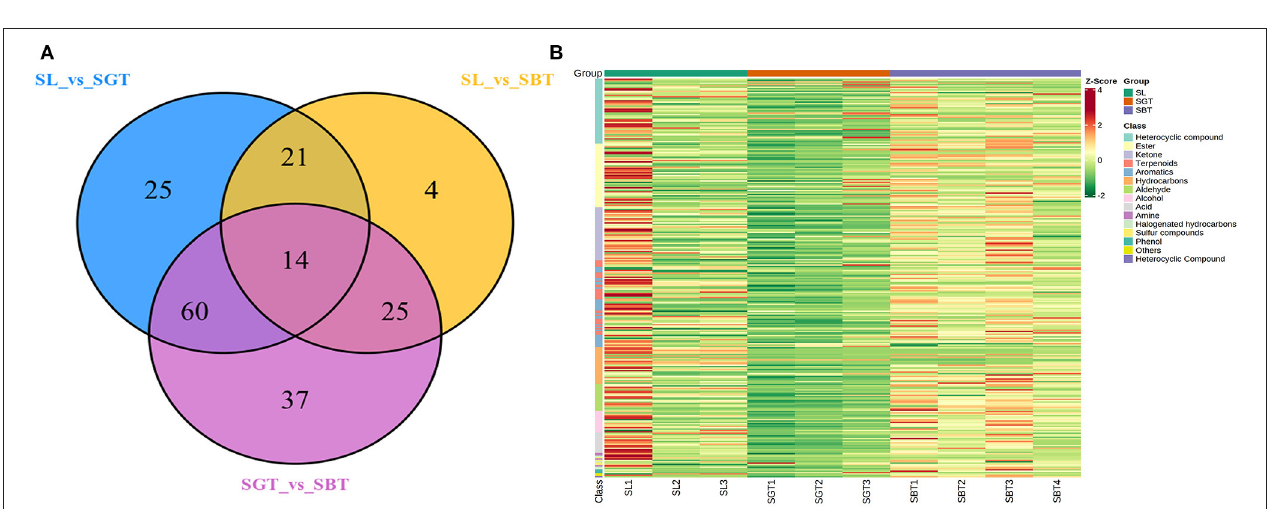
Frontiers in Nutrition |